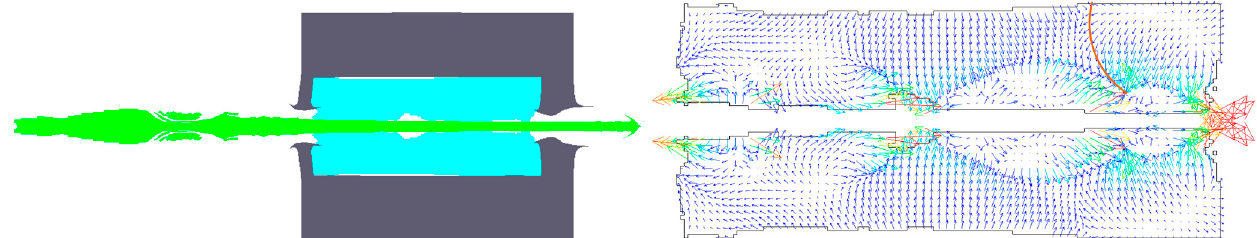
Figure 11. Propagation of the side-wall secondary reflection shock wave. The position, pressure, speed, and other parameters of the gauge points were obtained by using the data export function of the software. The position–time relationship curves of gauge points 9, 10, and 11 were plotted to obtain the motion trajectory of the three gauge points, as shown in Figure 12. The follow-up gauge point in the liquid goes through the reaming and reflux processes and then continues to oscillate but only slightly. Moreover, the trajectories of the three points are similar.